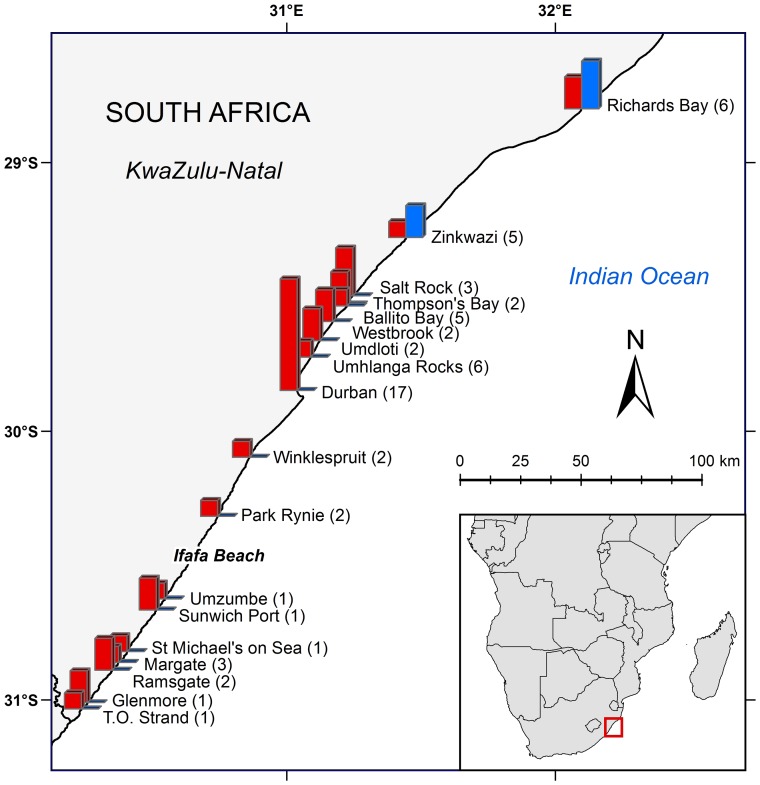
Location (beach name), number of shark nets per beach (in parenthesis) and number of T. aduncus (red) and S. plumbea (blue) sampled along the KwaZulu-Natal coast, South Africa.Gill nets are 110 m long and 10 m deep. Adapted from [87].